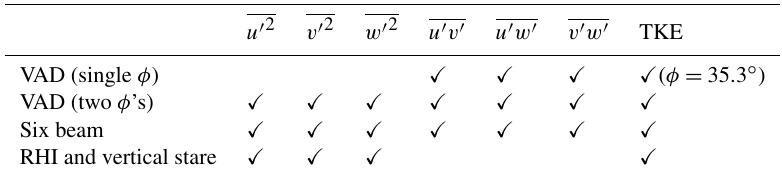
Figure 2. Sample RHI scan (a) showing instantaneous values of v rH over the scan plane. (b) Vertical profile of the mean v rH for the (c) . For each height bin between the solid horizontal black lines on (a) and (c) , the variance of v (cid:48) scan, which is used to calculate v (cid:48) rH calculated (d) . Table 1. Summary of measured variables for each type of scanning